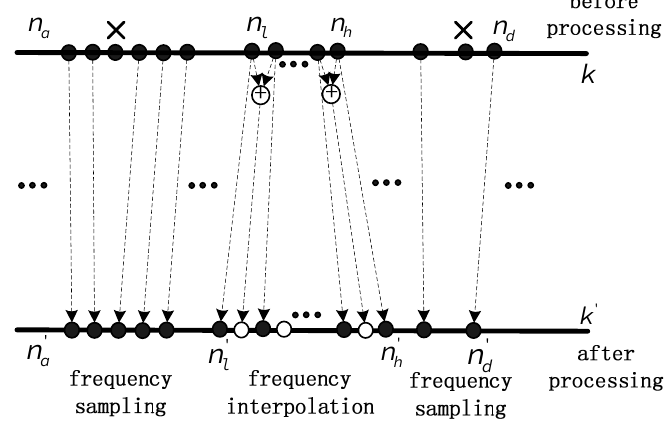
Figure 3. Frequency interpolation and sampling.